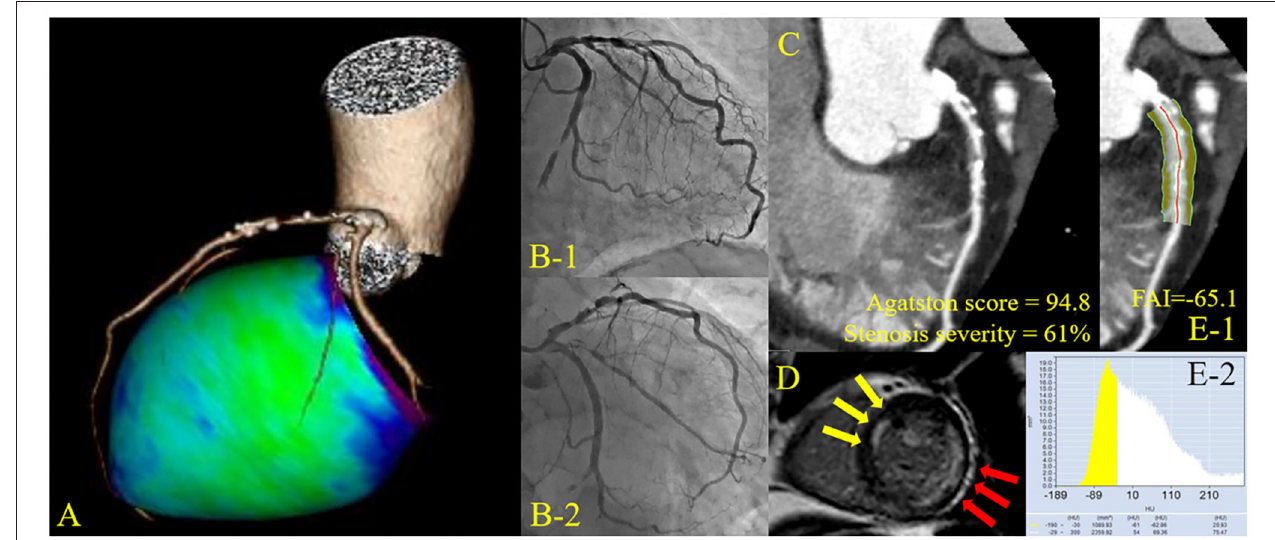
FIGURE 1 | Representative cardiac images of a patient with non-infarct-related unrecognized myocardial infarction. A 72-year-old man with a history of diabetes mellitus. (A) Three-dimensional reconstruction of the coronary artery. (B) Pre-percutaneous coronary intervention (PCI) angiogram reveals 99% stenosis in the left circumflex artery #13 (culprit lesion) and 75% stenosis in the left anterior descending artery #6 (non-culprit lesion). (C) Curved planar reconstruction view with Agatston score and computed tomography-derived stenosis severity. (D) Delayed enhancement cardiac magnetic resonance imaging shows infarct-related late gadolinium enhancement (LGE) in the lateral territory and non-infarct-related LGE in the anterior territory. (E) Peri-coronary fat attenuation index (FAI) at the proximal 40mm segment of non-infarct-related vessel (left anterior descending artery) was